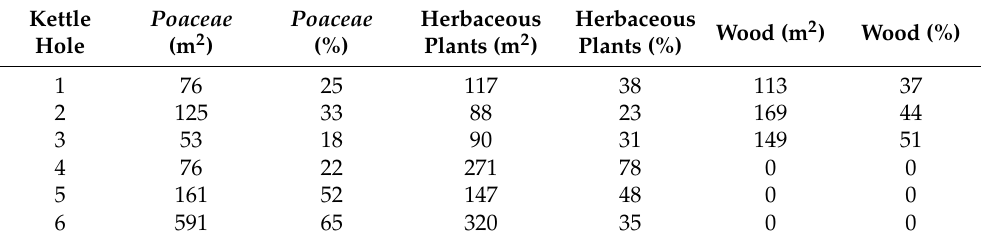
Table 5. The amount of plants ( Poaceae , herbaceous plants, woody plants) at the edges of six different kettle holes in m 2 and % sampled in 2019/2020. Vegetation at kettle holes edges was analyzed and digitalized in June 2020 by manual mapping in QGIS, based on orthomosaics. Poaceae Poaceae Kettle Herbaceous Herbaceous Wood (m 2 ) Wood (%) Hole (m 2 ) (%) Plants (m 2 ) Plants (%) 1 76 25 117 38 113 37 2 125 33 88 23 169 53 18 90 31 149 51 4 76 22 271 78 0 0 5 161 52 147 48 0 0 591